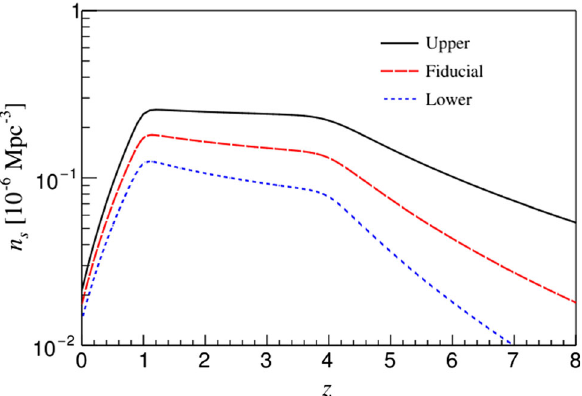
Fig. 1 Source density n s in function of the redshift z . We show n s for the three sets of parameters in Table 1: upper (black continuous curve), Fiducial (red dashed curve) and lower (blue dotted curve)